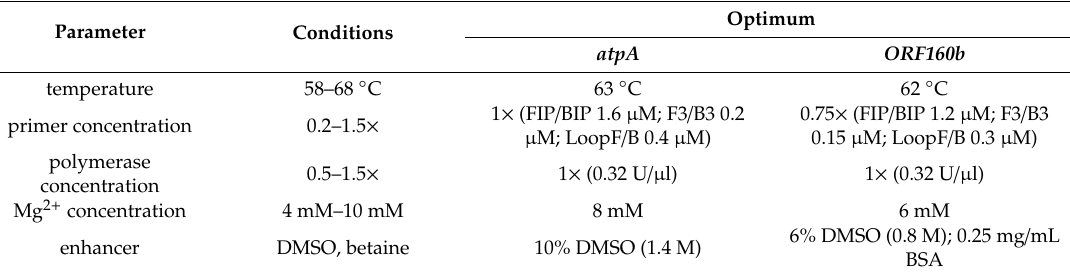
Table 7. LAMP optimization